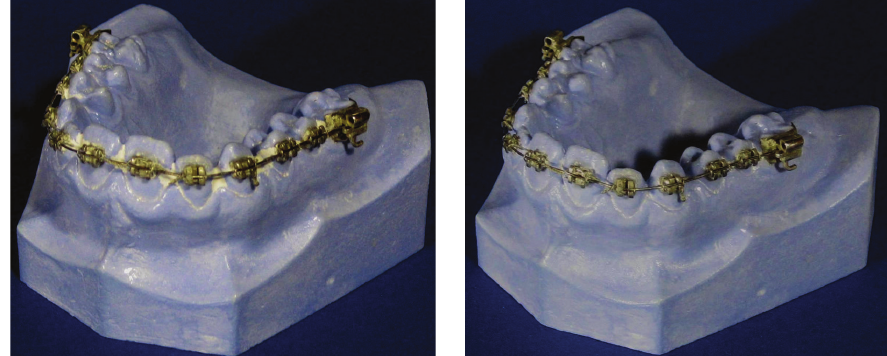
Figure 2: “Plaque simulator” residuals on the orthodontic model number 5, after manual brushing. On the left side the results for the normal toothbrush, on the right side the prototype